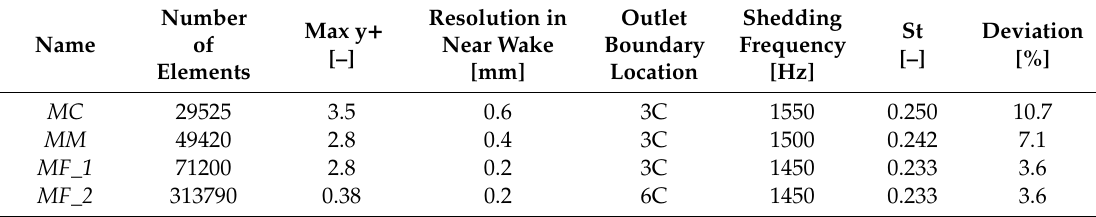
Table 1. Details of the checked meshes and results obtained for the mesh independency